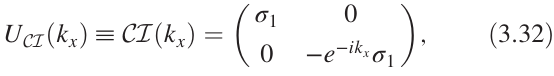
Fig. 6. The condition Pf ½ H ð k Þ(cid:3) ¼ 0 indeed matches the location of the FS given by Eq. (3.26). The FS is stable in